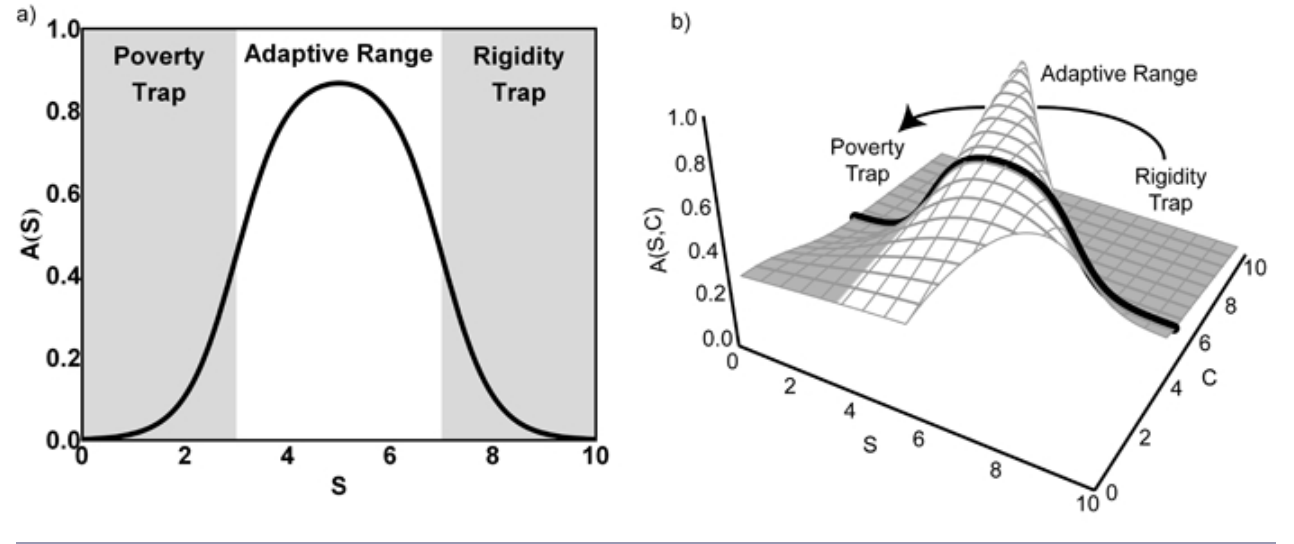
Fig. 4 . Figure 4(a) reproduces Carpenter and Brock’s (2008) figure relating adaptive capacity, A(S), to stress, S, for direct comparison to the new, extended figure provided in 4(b). Figure 4(b) incorporates insights from other resilience and development literature perspectives to extend Carpenter and Brock’s original model along a new axis of connectedness, C. The location of the original figure is indicated by the heavy line at C = 5. As connectedness increases, the performance of disparate parts of the system is bound together more tightly and the transitions between the ‘rigidity trap,’ ‘adaptive capacity, ’ and ‘poverty trap’ regions become more abrupt. At very low levels of connectedness a rigidity trap of the sort described in the resilience literature is not